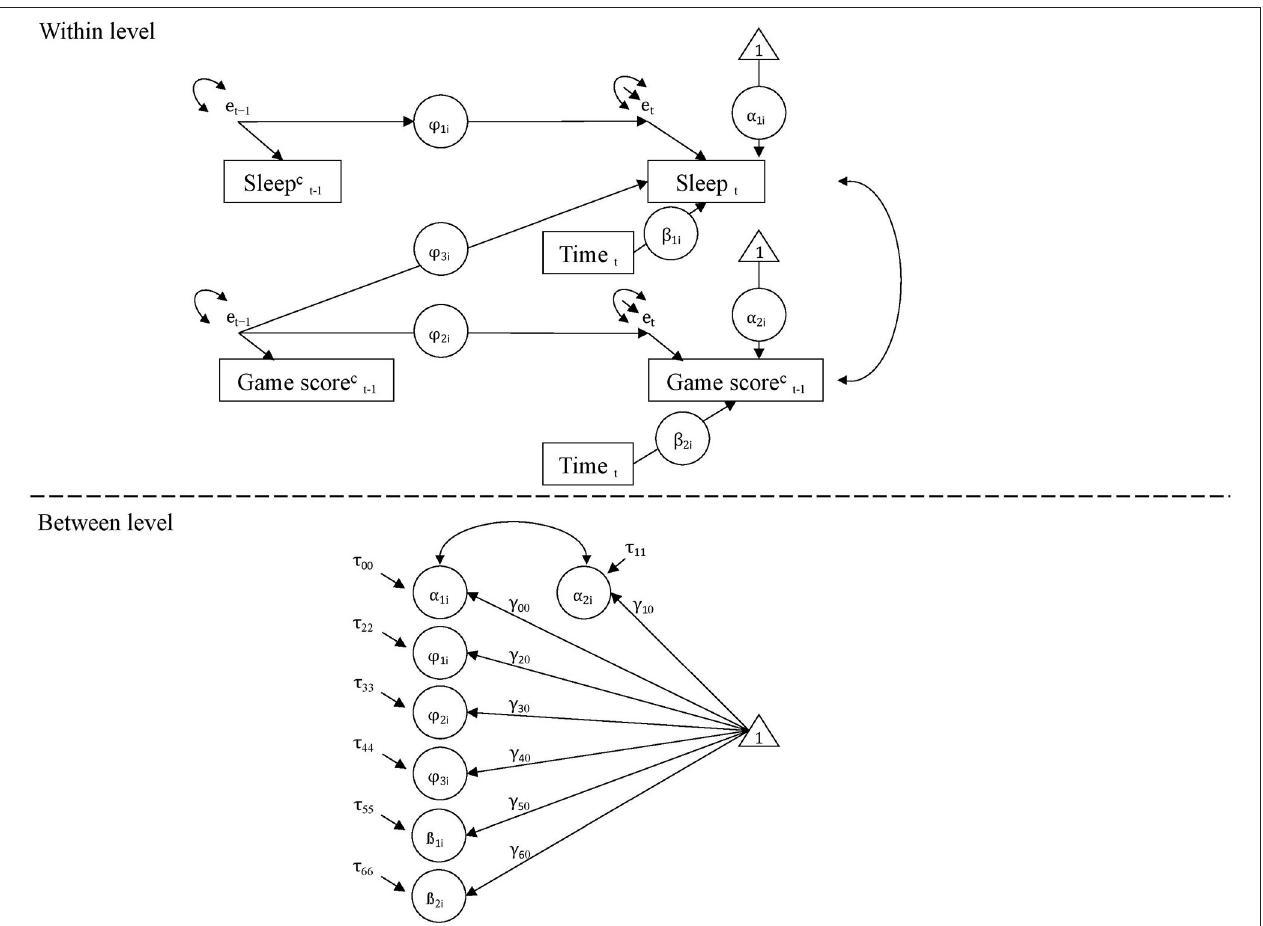
FIGURE 1 | Conceptual diagram of the residual dynamic structural equation model (RDSEM).